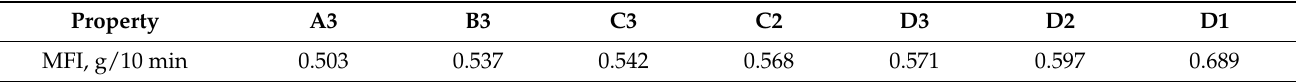
Table 6. MFI values of all the investigated